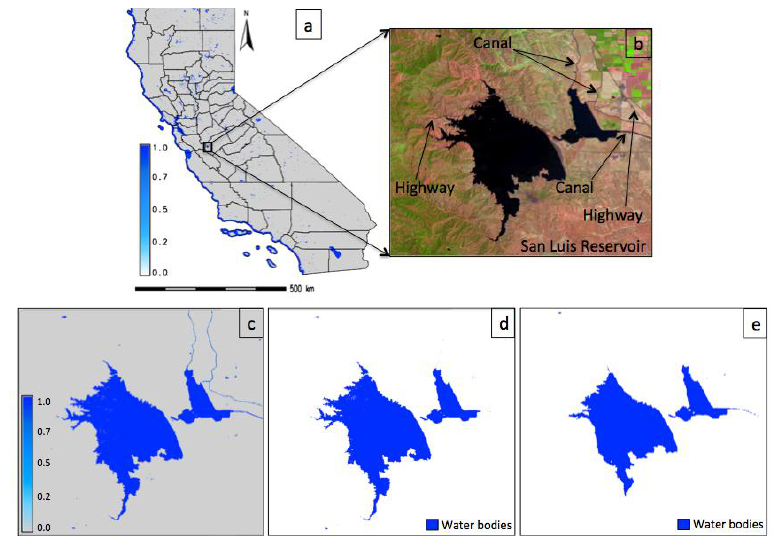
Figure 8. ( a ) Spatial distribution of the fractional water bodies in California; ( b ) RGB composite of the Landsat bands (3‒5) showing the San Luis Reservoir in central California; ( c ) fractional map of the San